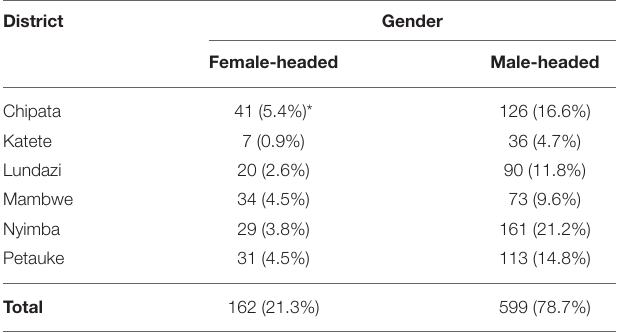
TABLE 1 | Distribution of survey respondents by gender, eastern Zambia. District Gender Female-headed Male-headed Chipata